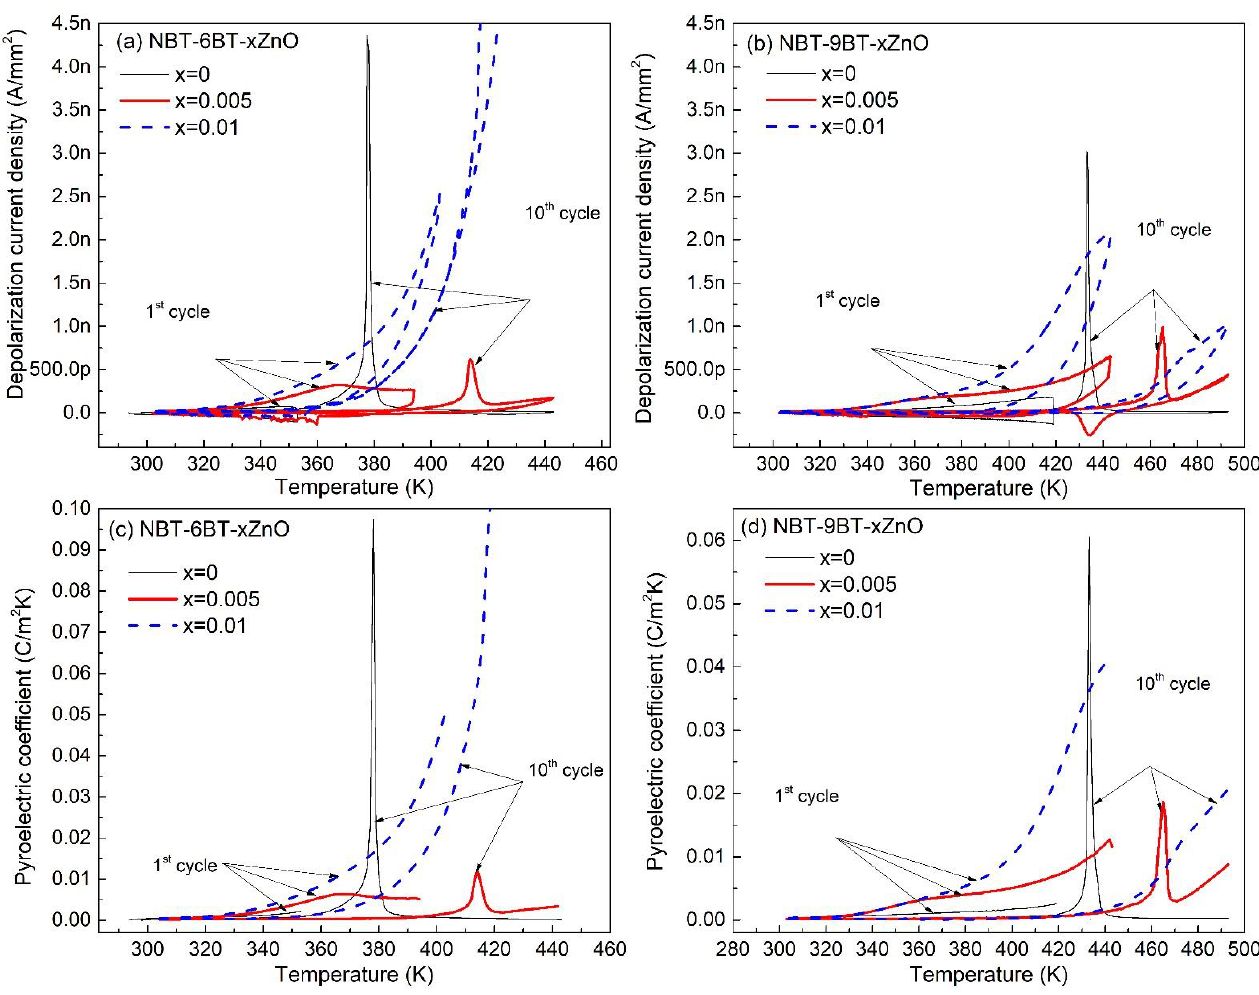
Figure 4. Depolarization current density and pyroelectric coefficient ( p ) for 1st and after 10th cycle as a function of temperature for ( a ), ( c ) NBT-6BT-xZn (x = 0, 0.005, 0.01) and ( b ), ( d ) NBT-9BT-xZn (x = 0, 0.005, 0.01), respectively.